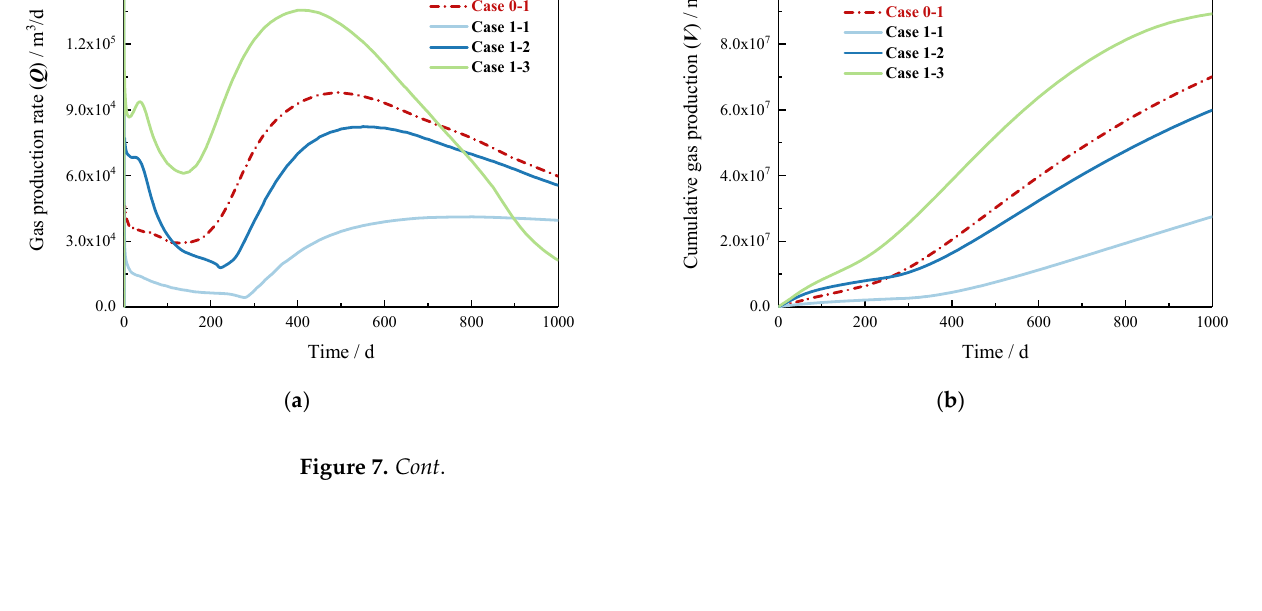
( d ) Figure 7. Gas production characteristics for the open-hole position adjustment: ( a ) gas production rate (1 MPa); ( b ) cumulative gas production (1 MPa); ( c ) gas production rate (4 MPa); and ( d ) cumu- lative gas production (4 MPa). 4.2.2. Inner Wall Heating NGH dissociation is an endothermic process, so excessive gas production may in- duce ice formation and NGH regeneration, which block the flow paths within sediments [26]. Compared to conventional wellbores, the SEED is made of steel, which is more con- ducive to heat transfer as a way to mitigate related problems. The SEED arrangement in the electrically heated model is the same as the control group, with the heating site being the open-hole section. In order to study the variation of gas production under different heating power (2 kW, 4 kW, and 6 kW), eight cases were established (Table 4). As shown in Figure 8, various heating power makes little difference in the early pro- duction stage, which is more obvious at P = 4 MPa. In the first 150 days, the curves oscil- lated down due to ice formulation and NGH regeneration, which indicates that the NGH decomposition at the beginning mainly relied on the depressurization drive, and inner wall heating played a relatively minor role. As production progressed, the heating effect began to make the gas production curve rise, and with the rise of heating power, the rise in the Q was more pronounced. However, In the late production period, the Q curve started to fall back and almost coincided with the control case, while at P = 1 MPa, Q was even lower than the control case. This is because the NGH near the SEED decomposed fully in this stage, but that portion of the heat generated by inner wall heating has a re- stricted range of influence and has little effect on the NGH decomposition farther away.